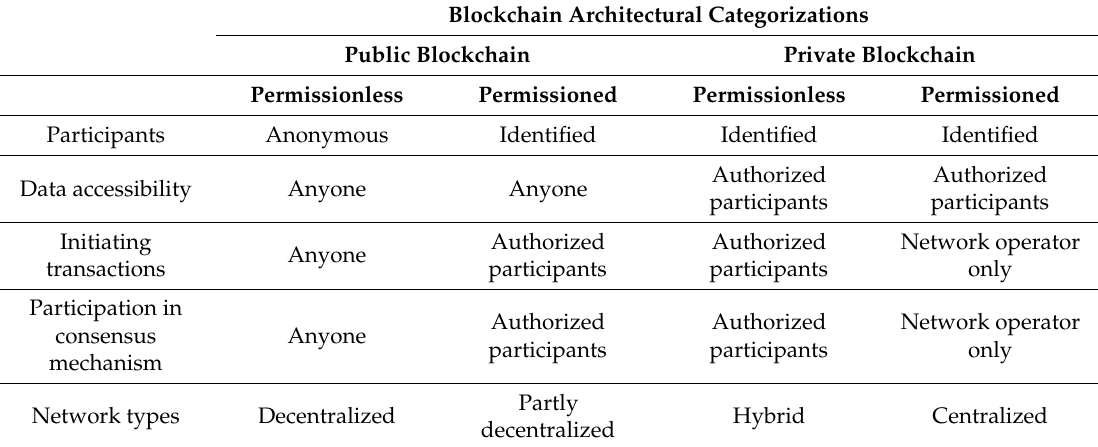
Table 3. Blockchain architectural categorization Source: adopted from